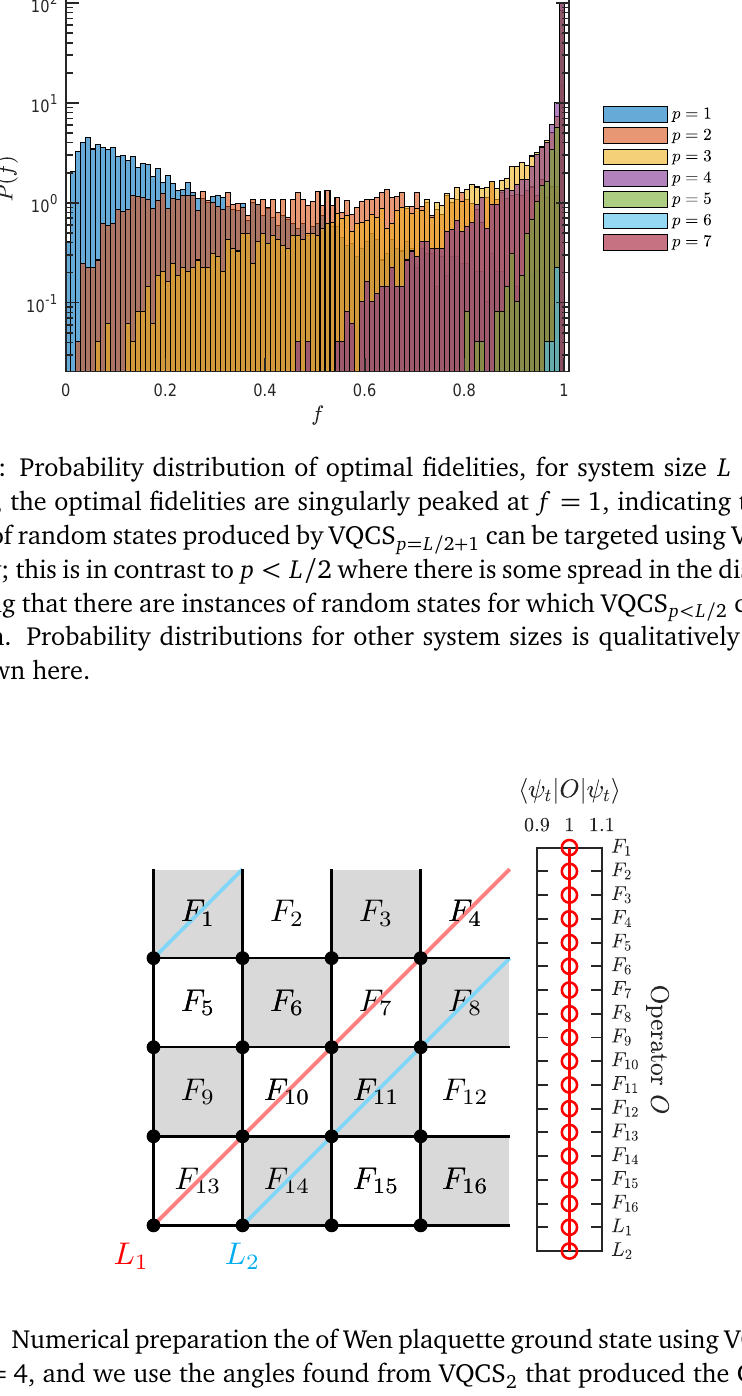
Figure 9: Numerical preparation the of Wen plaquette ground state using VQCS . p = L / 2 Here L = 4, and we use the angles found from VQCS that produced the GHZ state. 2 The left plot describes the geometry of the set-up, and illustrate the plaquette op- = − (cid:80) F erators F which make up the Hamiltonian H as well as the two logical i T i i operators L and L which wrap around the torus. The right plot shows the expec- 1 2 tation value of the plaquette operators and logical operators in the state prepared by VQCS. One sees that all expectation values are + 1 to machine precision, indicating a perfect preparation of the ground